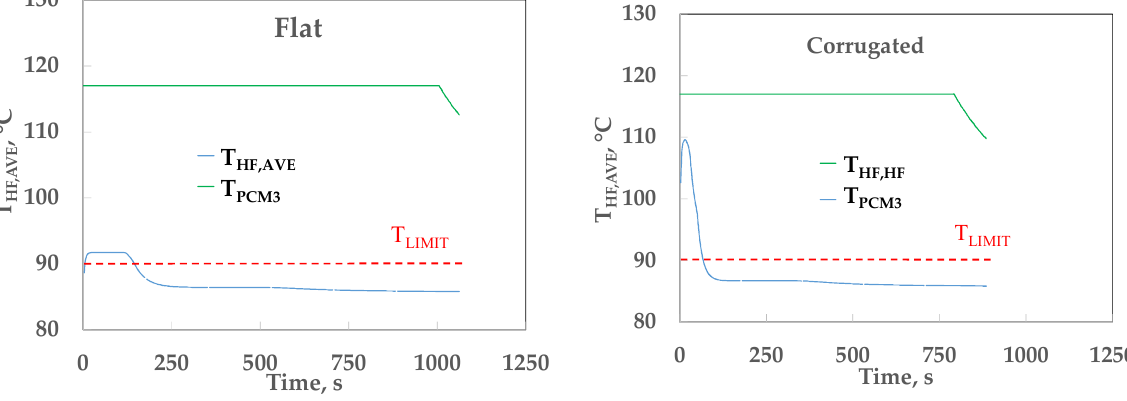
Figure 13. Outlet temperatures of the latent heat storage at different discharge temperatures at a flowrate = 0.8 kg/s.